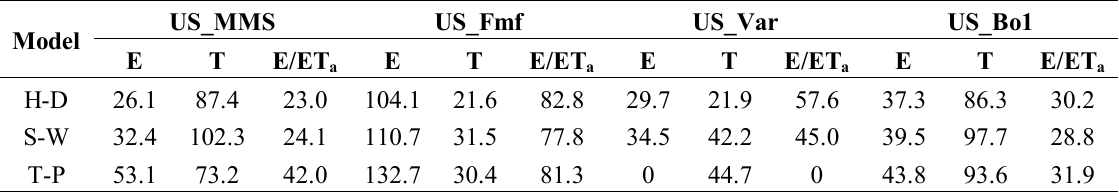
Table 3. Summary of mean evaporation (E, W/m 2 ), mean transpiration (T, W/m 2 ), and the ratio of E/ET (%) at four sites during study